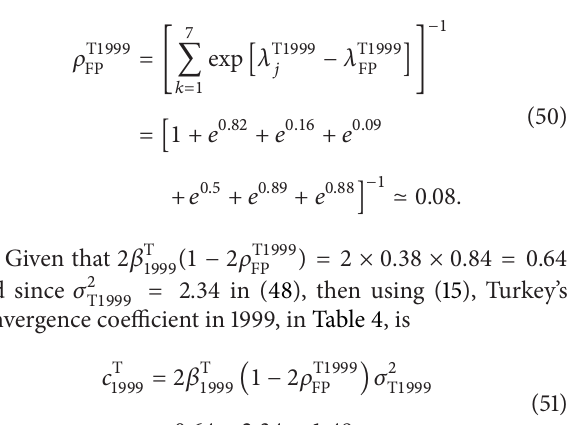
of negotiating a coalition compromise across the disparate policy positions of the coalition members.